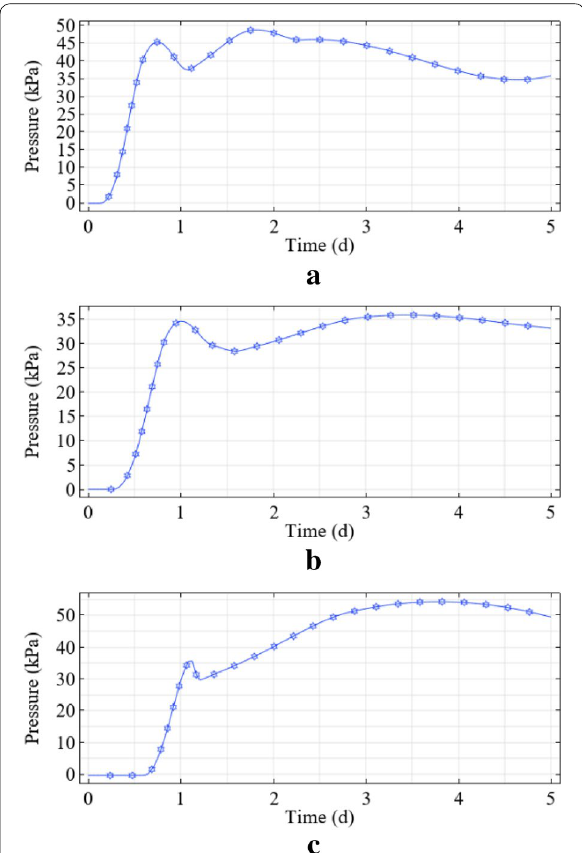
Fig. 7 Evolution of the simulated barricade pressure with time corresponding to the data of TEPC1 ( a ), TEPC2 ( b ) and TEPC3 ( c